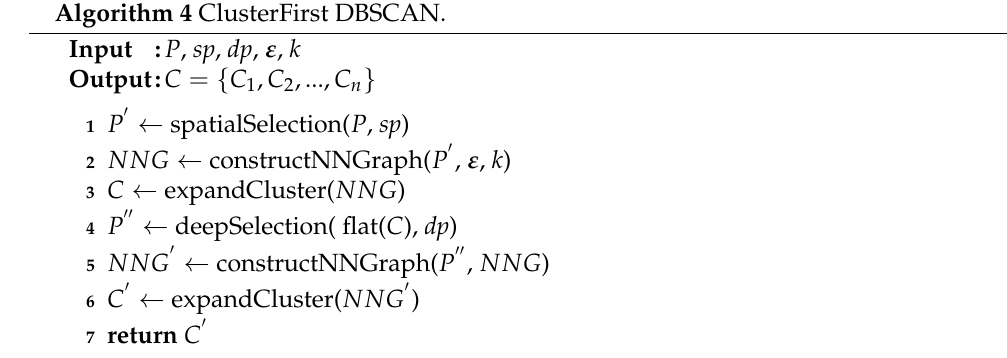
Algorithm 4 ClusterFirst